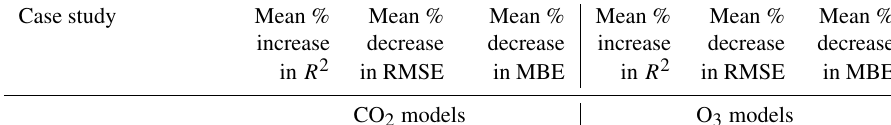
Table 7. Relative benefits associated with the implementation of different models for O 3 and CO 2